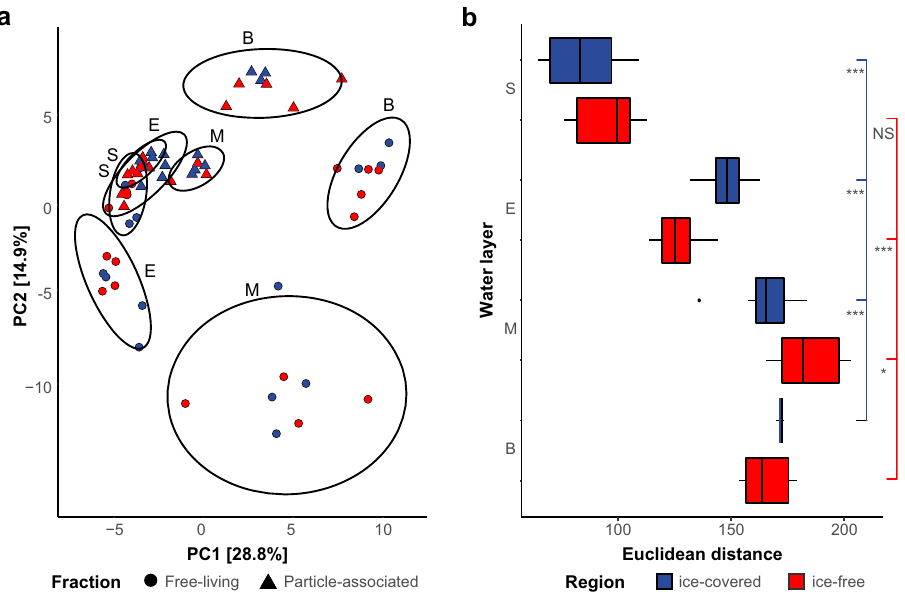
Fig. 3 Free-living and particle-associated community patterns throughout the water column of the Fram Strait. a Principal component analysis (PCA) of microbial communities. Ellipses encompass clustering of each of the fractions by water layer (S-surface, E-epipelagic, M-mesopelagic, B-bathypelagic), with normal con fi dence of 0.95. The percentages on both axes represent the explained variance of the axis. b Euclidean distances between FL and PA communities in each water layer. The colors represent different geographic origins: ice-covered (blue) and ice-free (red) regions. Results of Wilcoxon signed-rank test are represented on the right edge of the fi gure: (NS) - not signi fi cant, p -adjusted > 0.05; (*) - p -adjusted < 0.05; (**) - p -adjusted < 0.01; (***) - p -adjusted <